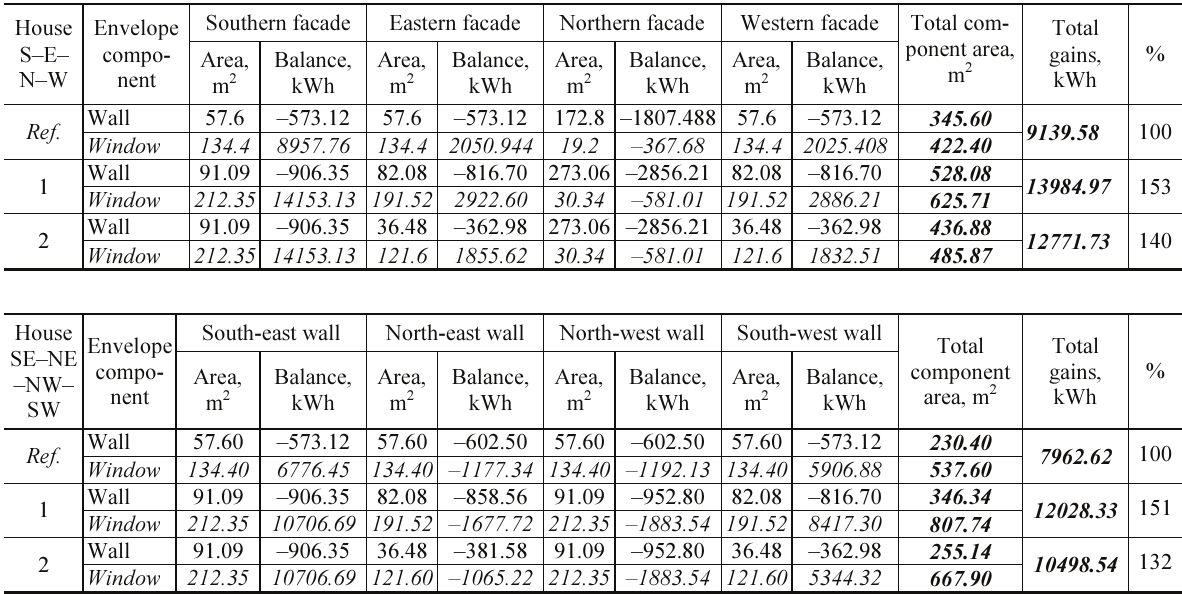
Table 6. Heating season energy balance per vertical components of building envelopes oriented toward S-E-N-W; SE-NE-NW-SW